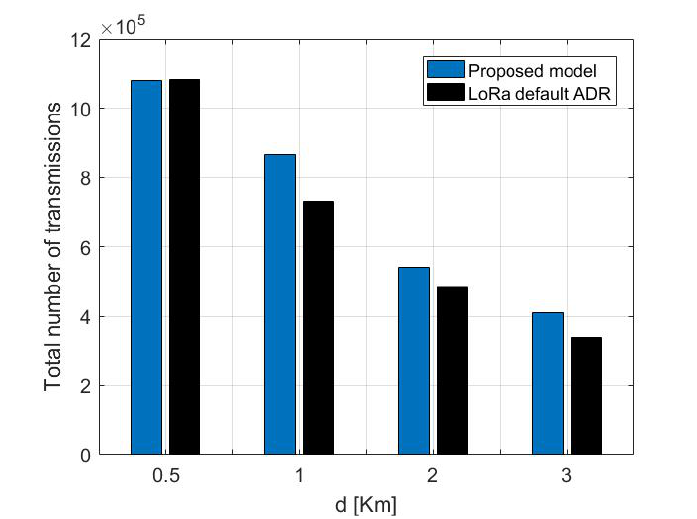
Figure 14. Total number of succeed transmission of the proposed model against LoRa default ADR for distinct distances transmitting a payload of a 30 Bytes.